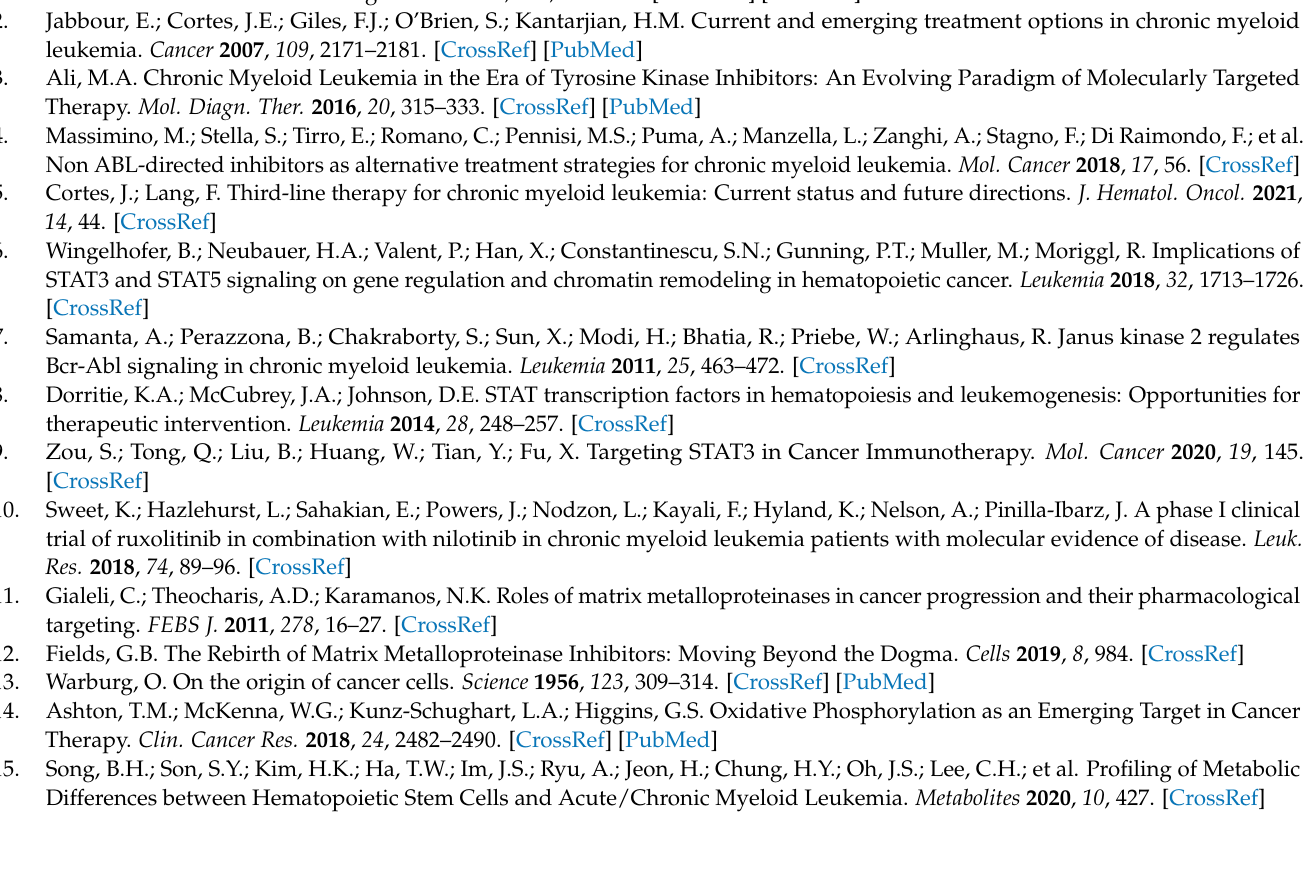
Table S2: Pathway and network associated with downregulated DEGs of 8-OHD-treated samples (H1 and H5) via the MetaCore platform; Table S3: Top KEGG pathways associated with putative targets of 8-OHD against myeloid leukemia (ML); Figure S1: Western blotting analysis of BAX expression in response to 8-OHD